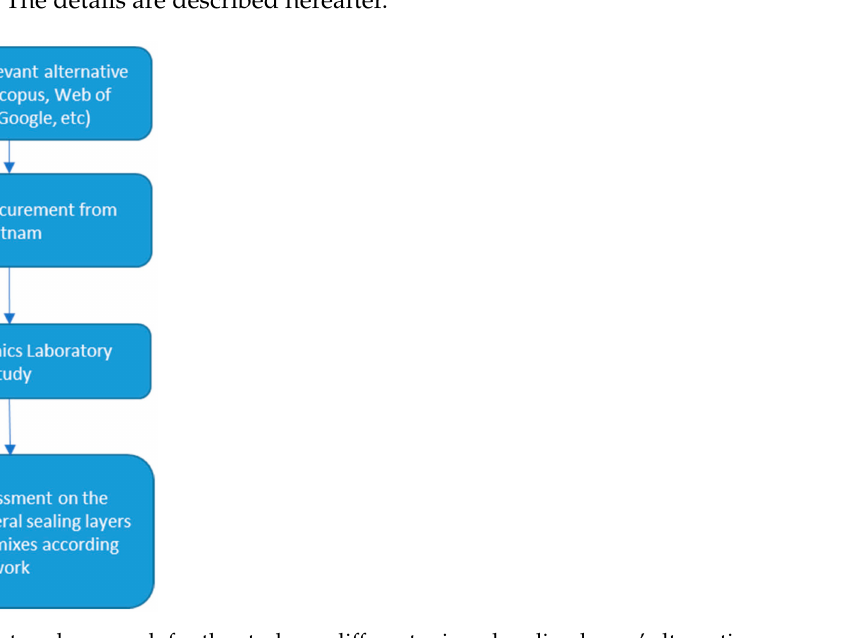
Figure 2. Structured approach for the study on different mineral sealing layers’